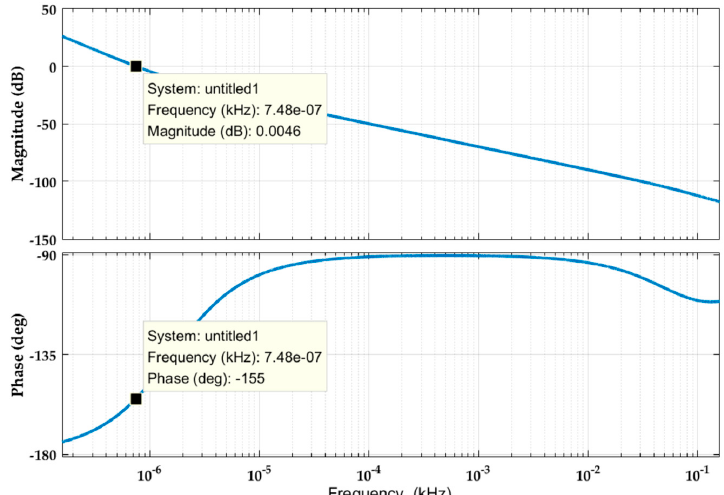
Figure 12. Bode plot of the voltage control loop gain.